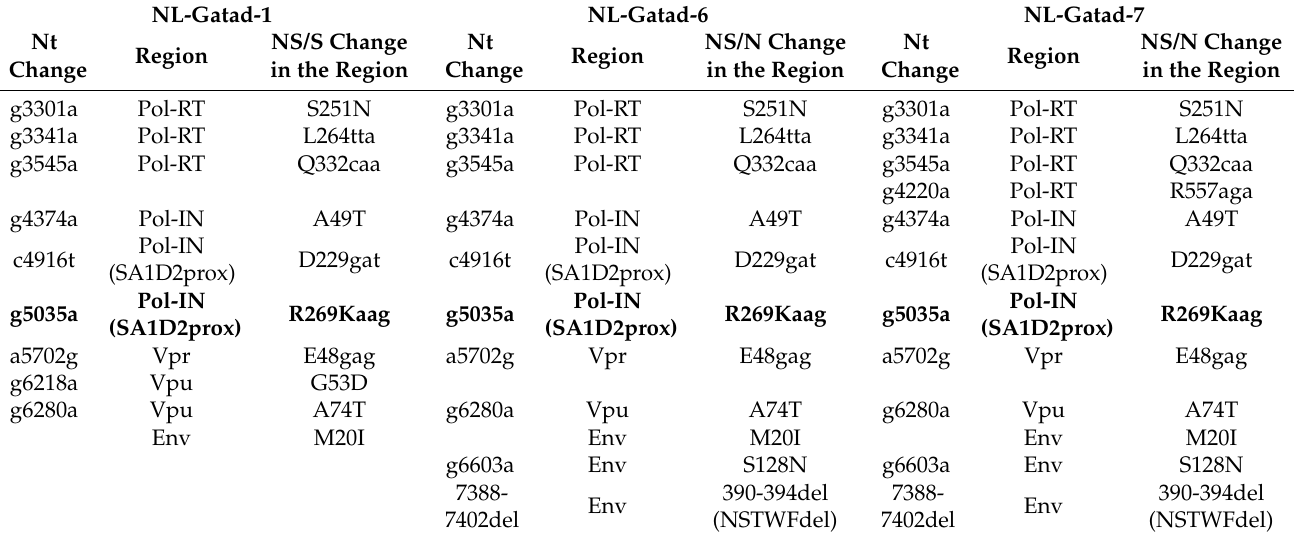
Bold letters show adaptive mutations that change the Vif expression levels of a parental NL-D229gat clone. Nt, Nucleo- tide; NS, non-synonymous; S, synonymous.